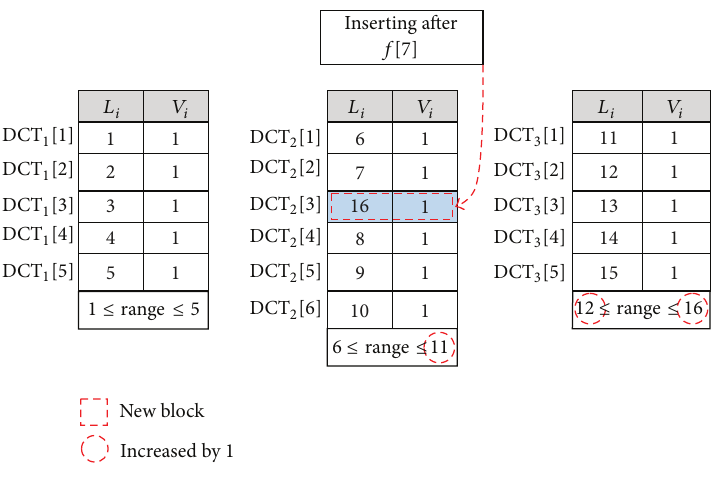
Figure 3: Inserting a new data block after 𝑓[7] when the number of blocks in each table is